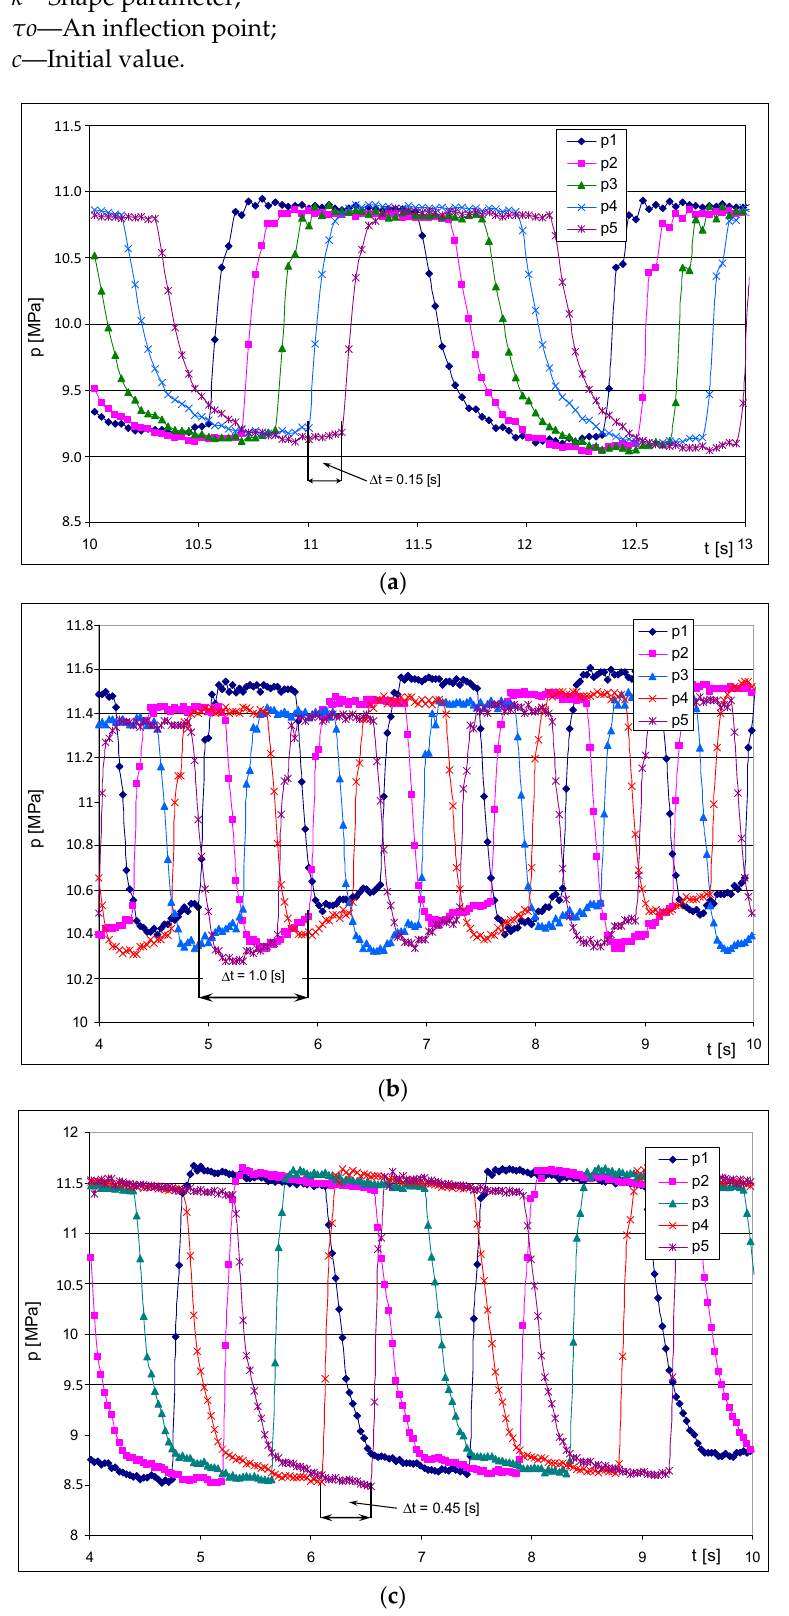
Figure 5. Sample of pressure oscillations for multiple sensors: ( a ) R134a with d iD = 1.40 mm; ( b ) R1234ze with d iD = 1.92; ( c ) R1234yf and with d iD = 3.30.